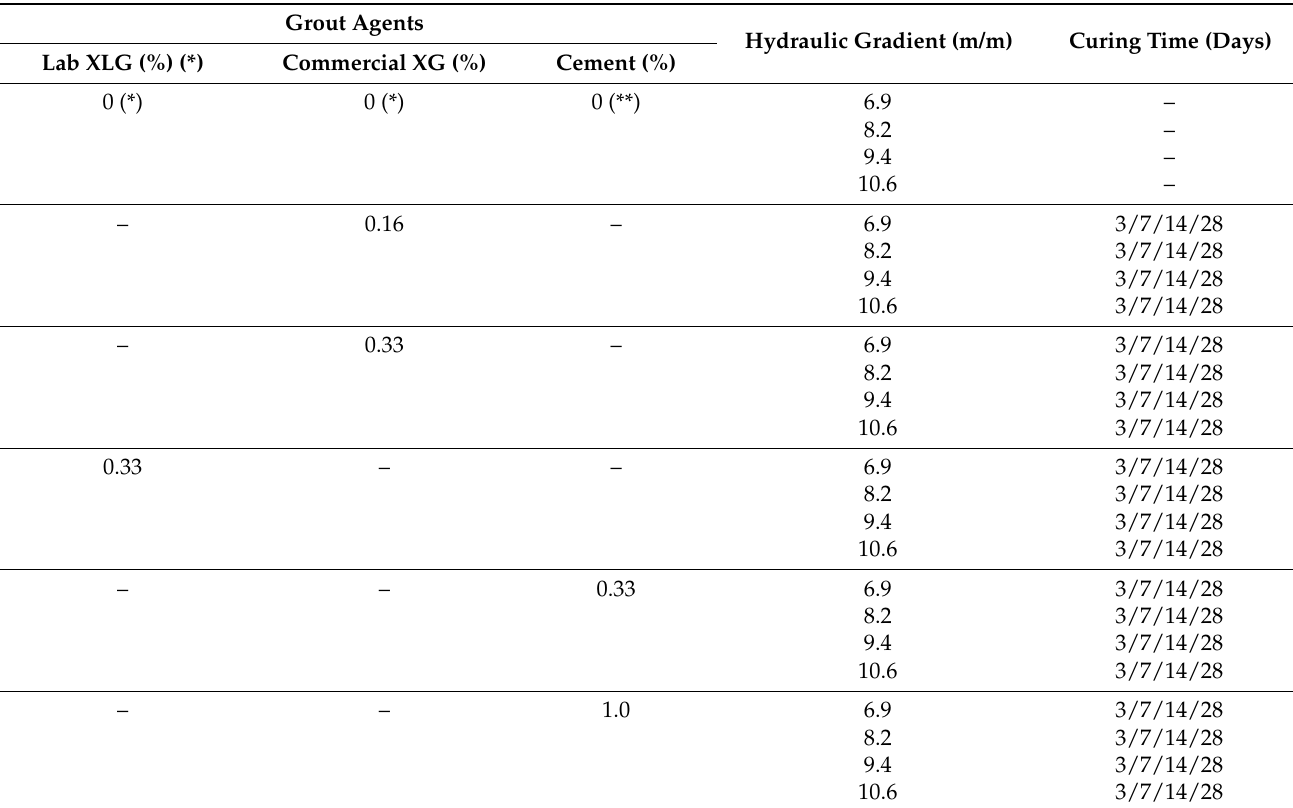
Table 2. Testing